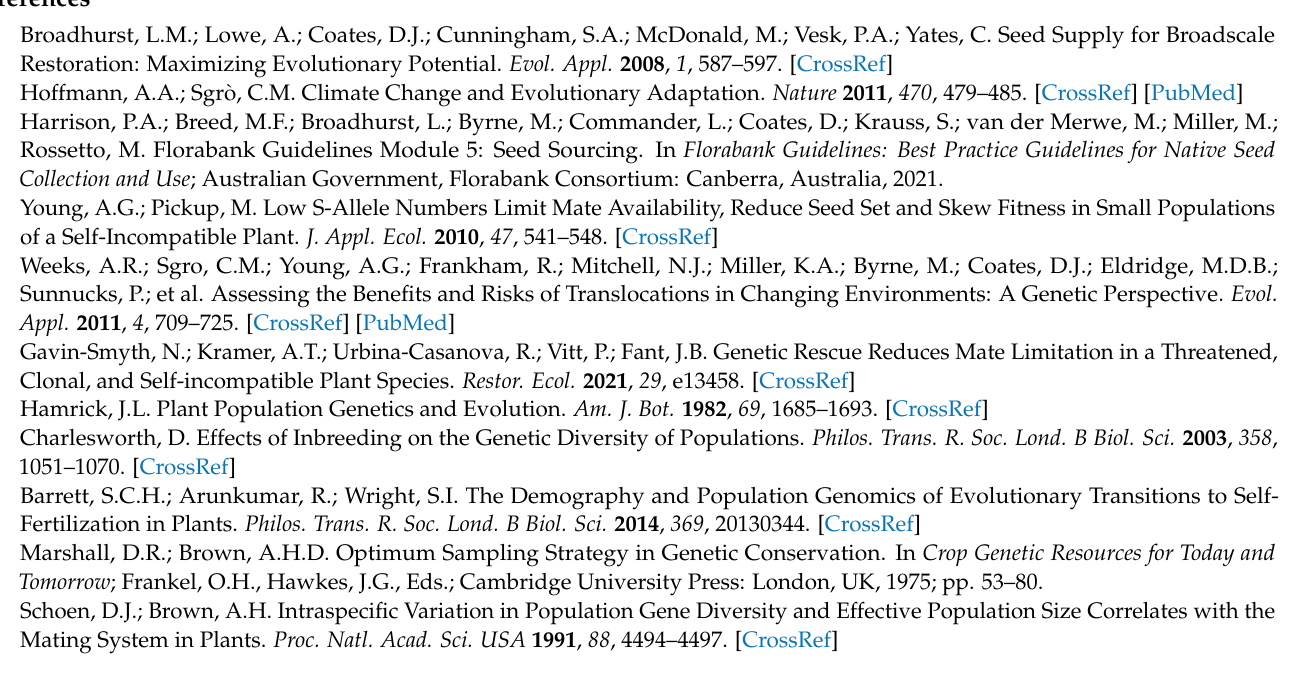
Table S3: Estimates of genetic diversity for seed sampling sites; Figure S1: Individual progeny selfing rates inferred per site (including site PT); Figure S2: Measures of error in selfing rate estimates; Figure S3: Genetic distance matrices among H. sericea individuals from sites PT and SP; Figure S4: Progeny array pairwise kinship coefficient estimates by known relationship; Figure S5: Loss of heterozygosity in progeny by selfing rate; Figure S6: Maximum proportions of alleles captured by resampling